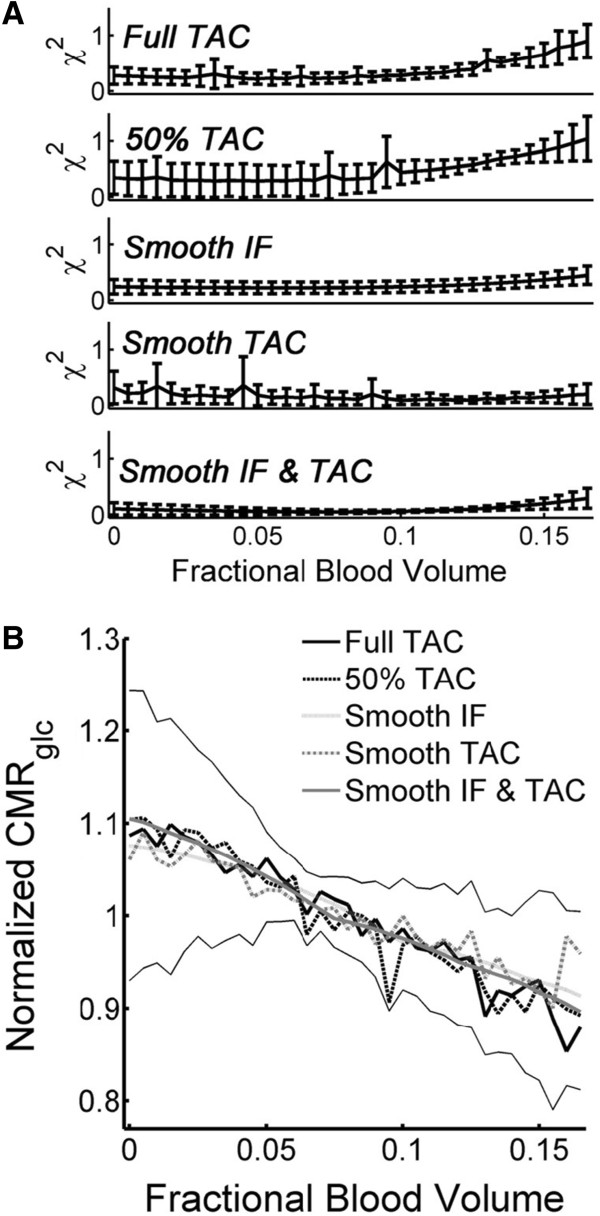
Effect of fractional blood volume on modeling with data from the cortex. (A) Effect on goodness of fit (χ2). Original data were more sensitive to unrealistically high vb in the model. (B) Averaged CMRglc was increased by about 10% when vb was assumed to be zero. Thin lines are drawn one average standard deviation of the experimental data (n = 5 animals) above and below the average data curve.